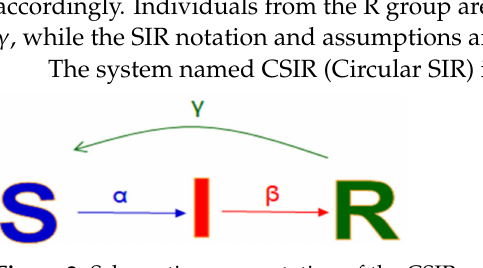
Figure 2. Schematic representation of the CSIR